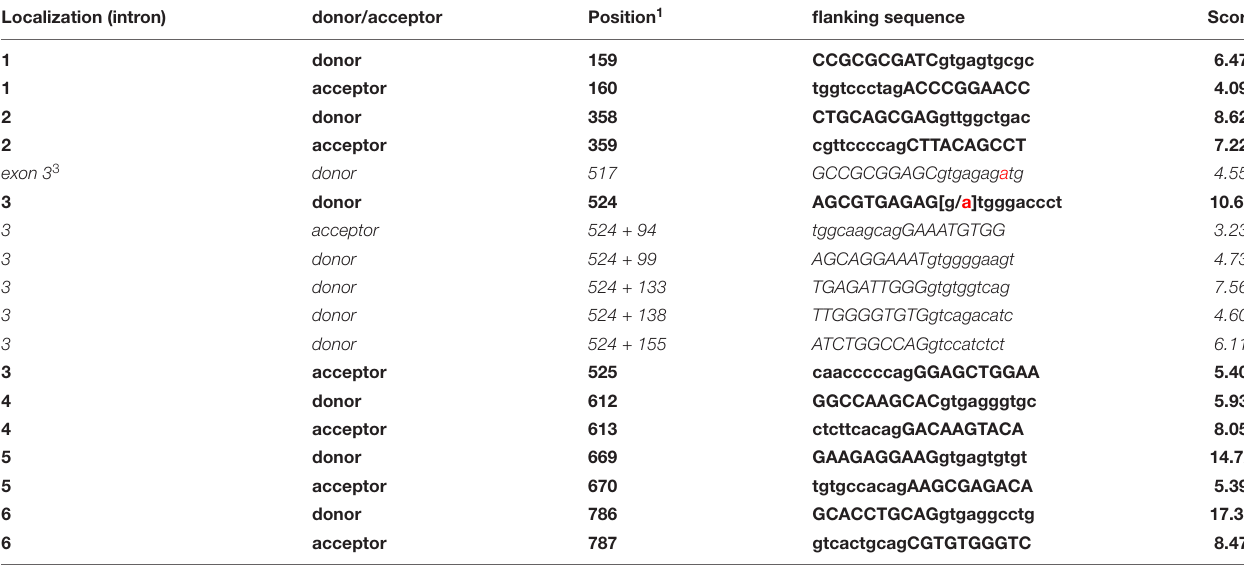
Localization of wild type splice sites are given in bold. Alternative/cryptic splice sites are given in italic. 1 First or last cDNA position of the corresponding exon is given. Exonic sequence is given in capitals, intronic sequence in lower letters. Pathogenic variant c.524+1G > A is highlighted in red. 2 Scores were generated with the Alternative Splice Site Predictor (ASSP). Scores of the preprocessing models reflecting splice site strength, i.e., a position specific score matrix for putative acceptor sites, and a maximum dependence decomposition model for putative donor sites (Wang and Marín, 2006). 3 This splice donor located in exon 3 was predicted only in the presence of the pathogenic variant c.524+1G >